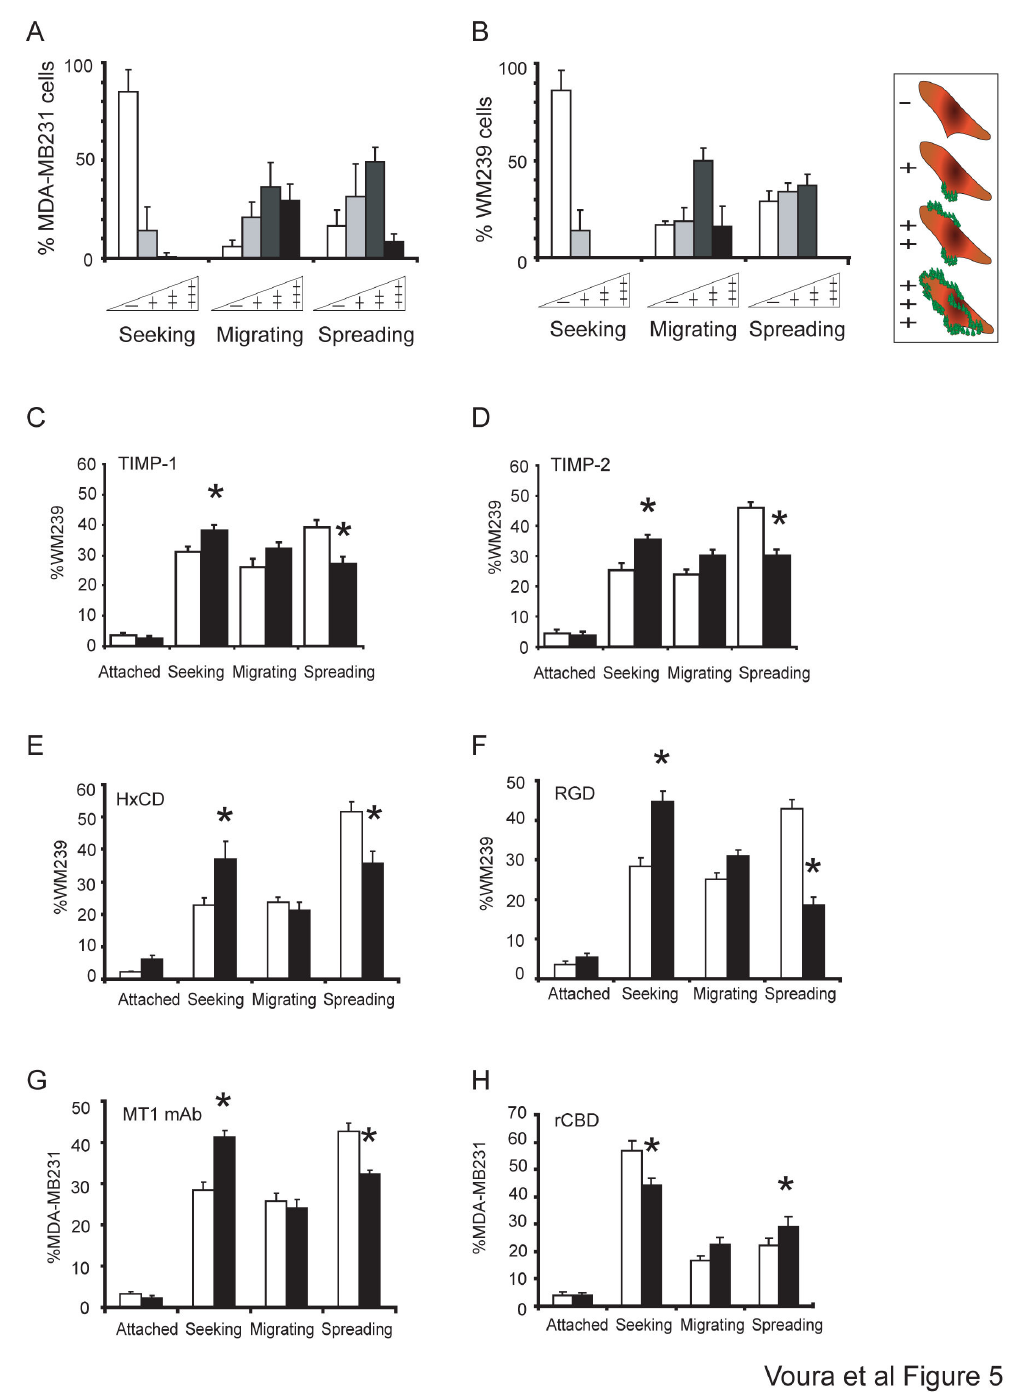
Figure 5. The migratory stage is most dependent on protease activity. Patches of FITC-matrix digestion were scored for both MDA-MB231 (A) and WM239 (B). “-“ = no digestion around cell contours, “+” = single patch of digestion, “++” = patchy digestion and “+++” = digestion around the entire cell contour. The cartoon panel on the right represents the scoring scheme. Error bars=mean ±S.E.M.. Percent WM239 cells at each stage of extravasation upon treatment with (C) TIMP-1 and (D) TIMP-2. Percent WM239 cells at each stage of extravasation upon treatment with (E) HxCD or (F) RDG peptide. Percent MDA-MB231 cells at each stage of extravasation upon treatment with the (G) MT1-MMP blocking antibody and (H) CBD. In graphs C-H, treated cells (black bars) are compared to untreated controls (white bars). Error bars=mean±S.E.M.. doi: 10.1371/journal.pone.0078413.g005 PLOS ONE |